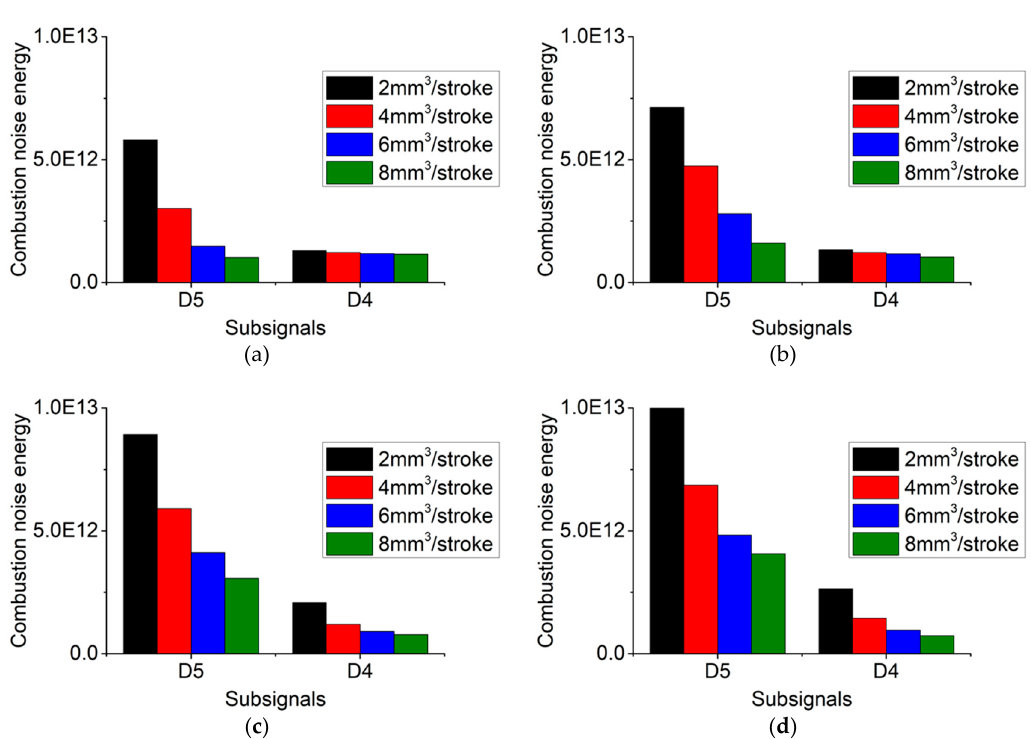
Figure 8. Main combustion noise energy of D4 and D5. ( a ) Pilot injection timing = − 9° ATDC; ( b ) pilot injection timing = − 14° ATDC; ( c ) pilot injection timing = − 19° ATDC; ( d ) pilot injection timing = − 24° ATDC.